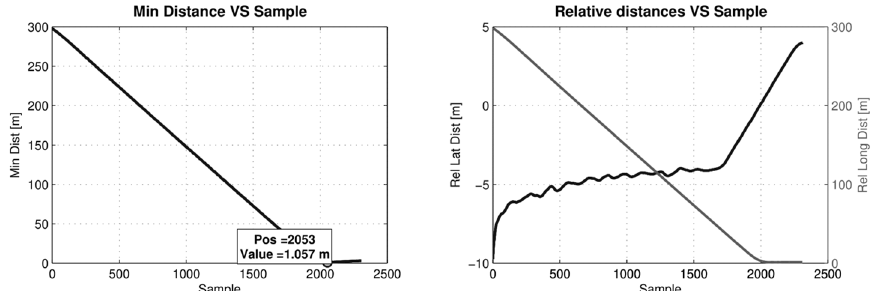
Figure 27. UNECE R152 CPNC 55 km/h PDF export: actors positioning and minimum distance rep- resentation; minimum distance versus time sample graph; relative longitudinal and lateral distances versus time sample graph.